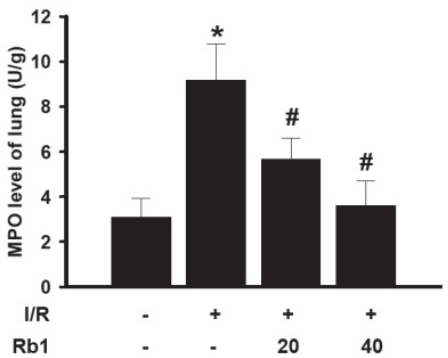
Figure 7. Effects of Rb1 on MPO levels of lung.